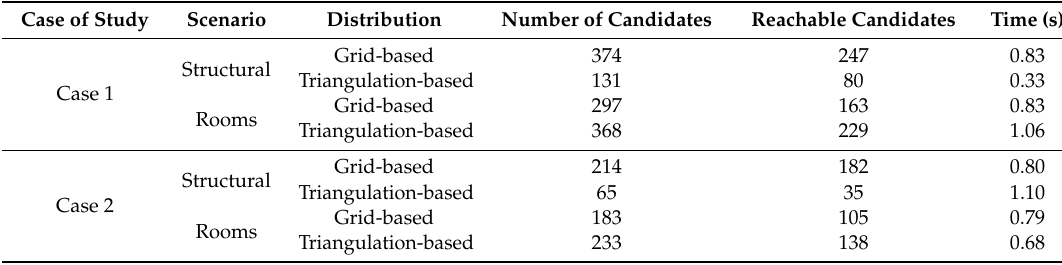
Figure 14. Candidate positions generated by both discretization methods in case study 1: ( a ) grid-based method in structural phase, ( b ) triangulation-based method in structural phase, ( c ) grid-based method with rooms and ( d ) triangulation-based method with rooms. Horizontal and vertical elements are displayed in magenta and black respectively. Green points represent position reachable by robotic system, unreachable positions are depicted in red. Table 3. Results distribution of candidate